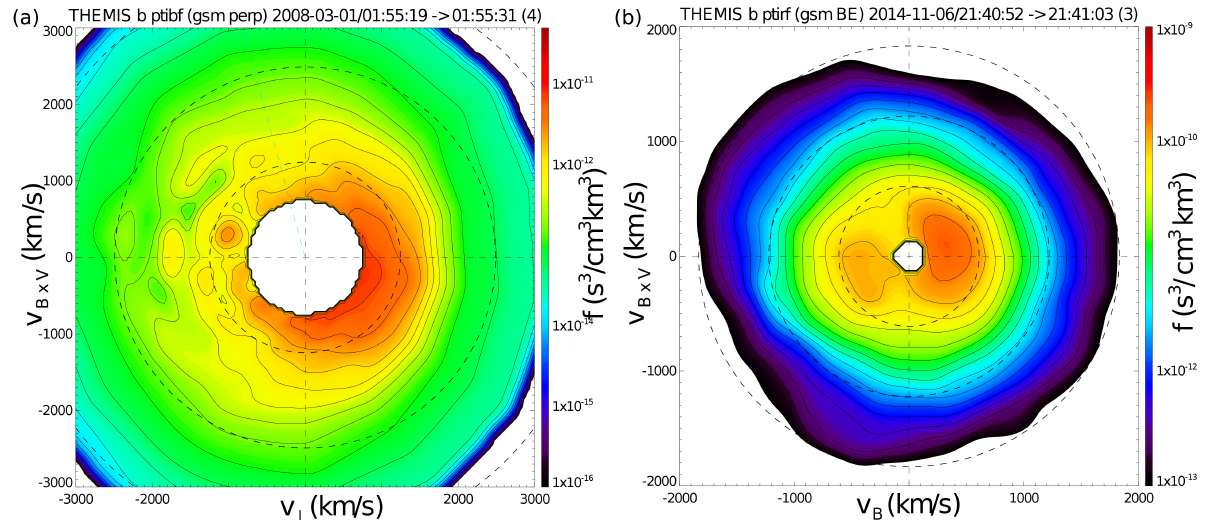
Figure 5. Examples of the ion velocity distribution functions observed within tailward reconnection outflows by THEMIS at X ∼ − 23 R E (a) and by ARTEMIS at X ∼ − 60 R E (b) . Shown are 3D velocity distribution cuts in the plane perpendicular to the instanta- neous magnetic field ( v ⊥ , v B × V ; a ) and in the plane that contains the magnetic field and the B × V vectors (b) . The distributions are shown in the bulk velocity frame. Dashed circles indicate [1, 2, 3] × V th , where V th is the ion thermal